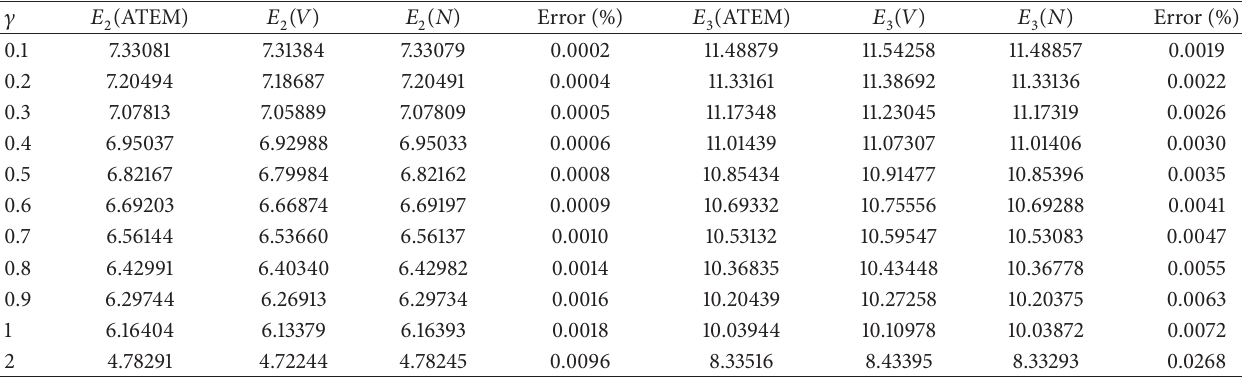
Table 3: Energy eigenvalues for the potential in (9) with different values of 𝛾 . 𝐸 2,3 (𝑉) and 𝐸 2,3 (𝑁) show the values obtained by variational supersymmetric method and numerical integration, respectively. The percent errors for ATEM are also shown in the fifth and ninth columns.